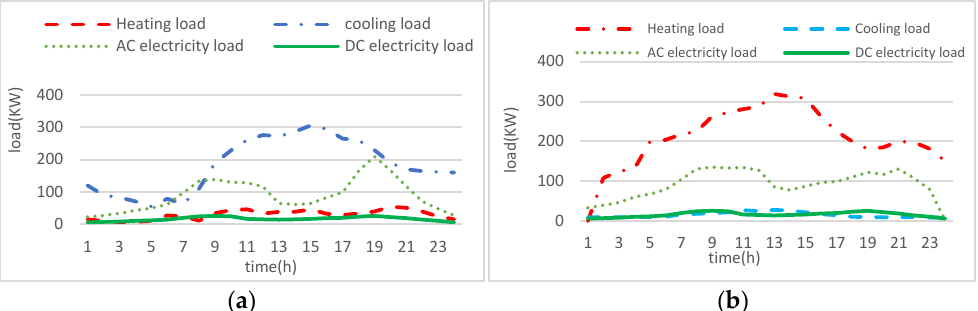
Figure 3. Electric, heating, and cooling loads: ( a ) sample winter day and ( b ) sample summer day.